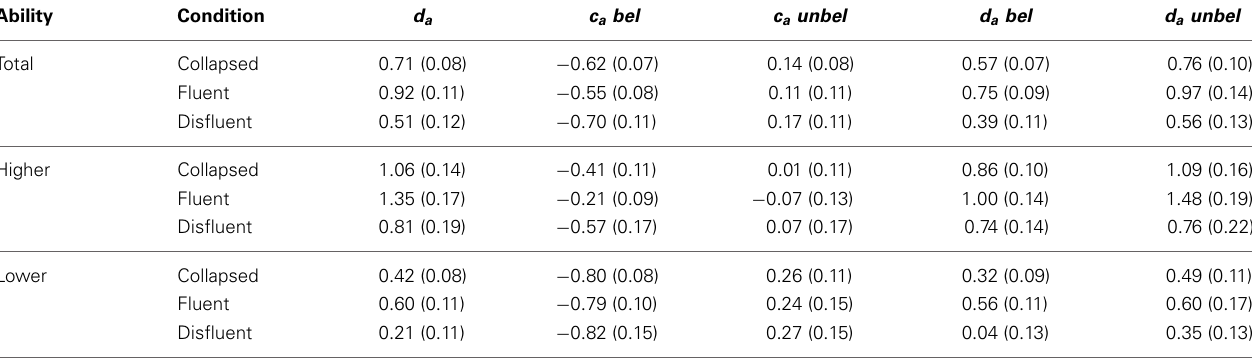
Table 1 | Reasoning accuracy and criterion placement per